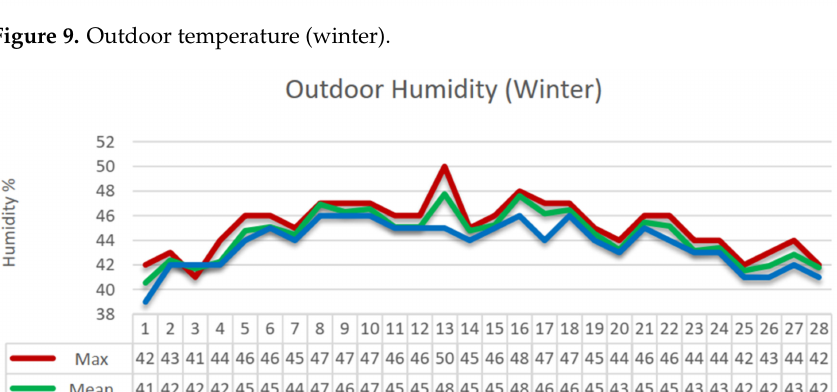
Figure 9. Outdoor temperature (winter).